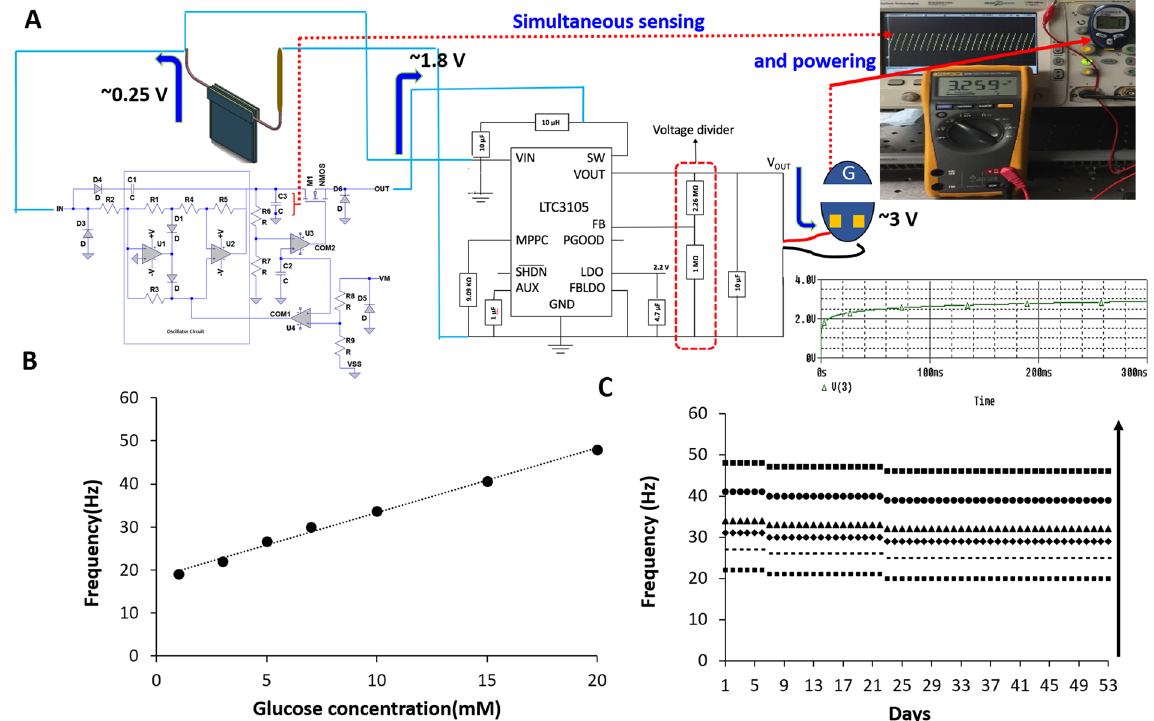
Figure 7. ( A ) Circuit block diagrams of the charge pump circuit interfaced to the step-up DC convertor and its application in powering a LifeStyle glucometer within 300 ms while sensing glucose via the charging/ discharging frequency of the capacitor; ( B ) Dependence of the charging/discharging frequency of the capacitor on glucose concentration, as measured with the self-powered glucose biosensing system [1, 3, 5, 7, 10, 15, 20 mM]; ( C ) Operational stability response of the self-powered glucose biosensing system in various glucose concentrations [3, 5, 7, 10, 15, 20